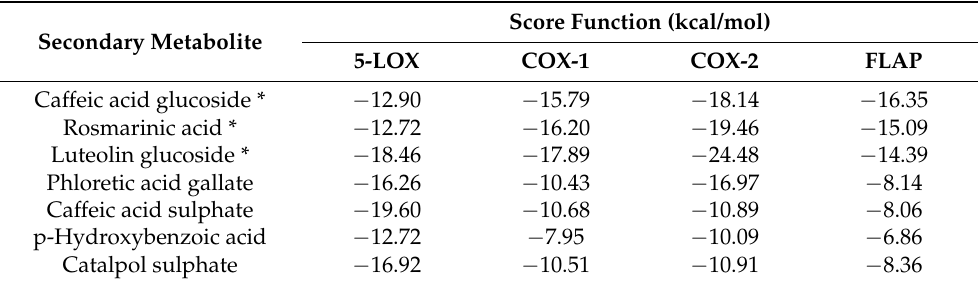
Table 4. Results from docking of selected compounds from P. perfoliatus extract into the binding sites of 5-LOX, COX-1, COX-2, and